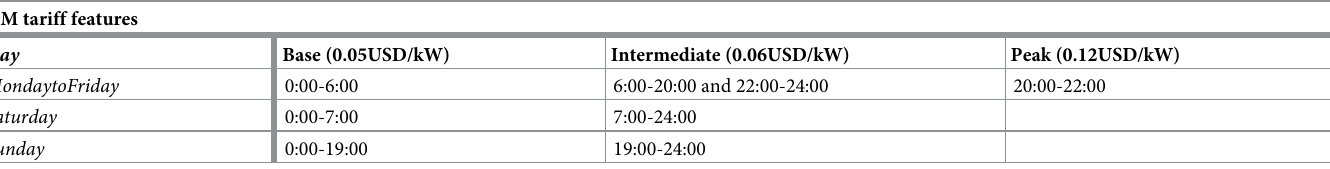
Table 3. HM region central tariff.